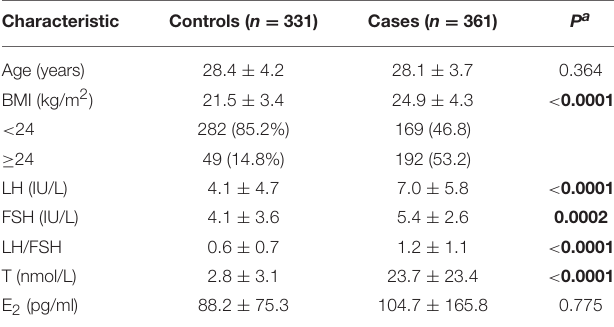
Continuous data were expressed as mean ± SD; BMI, body mass index; LH, luteinizing hormone; FSH, follicle-stimulating hormone; T, testosterone; E 2 , estradiol. a Boldface indicates P <